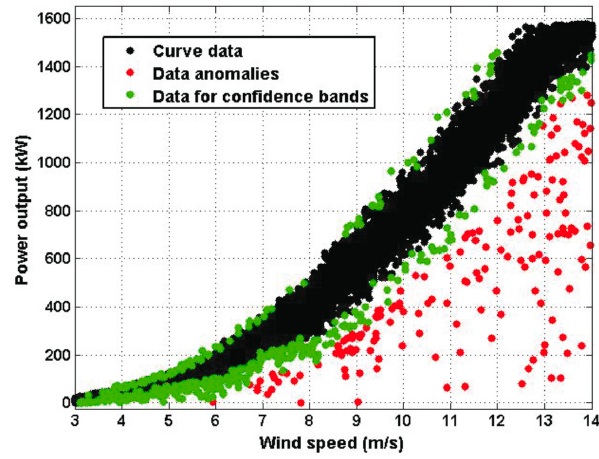
Figure 4. Robust classification of the data in the wind speed interval [3 m/s, 14 m/s]. Table 1. Estimated models for the power output.